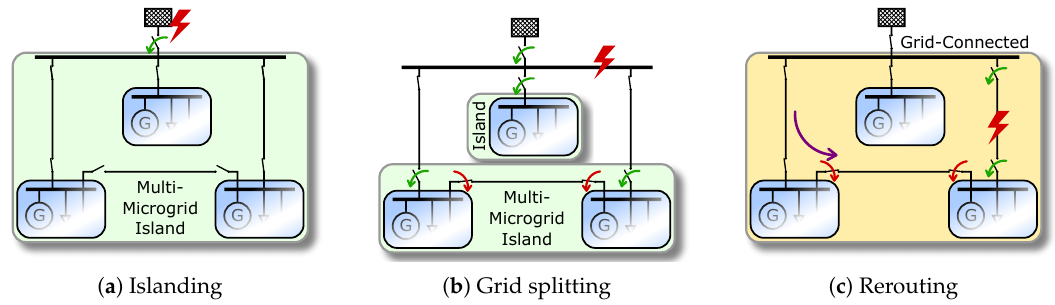
Figure 8. Observed mitigation